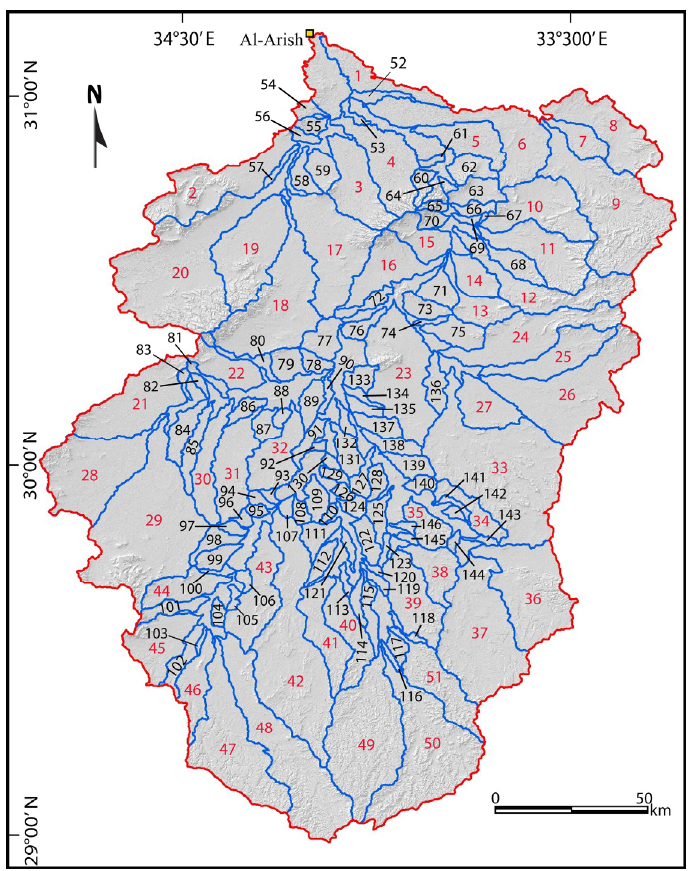
Figure 5. Shaded relief image (data from SRTM-30 resolution) of Wadi Al-Arish showing catchments/sub-catchments. Red numbers indicate catchments (1–51); black numbers indicate sub-catchments (52–146).